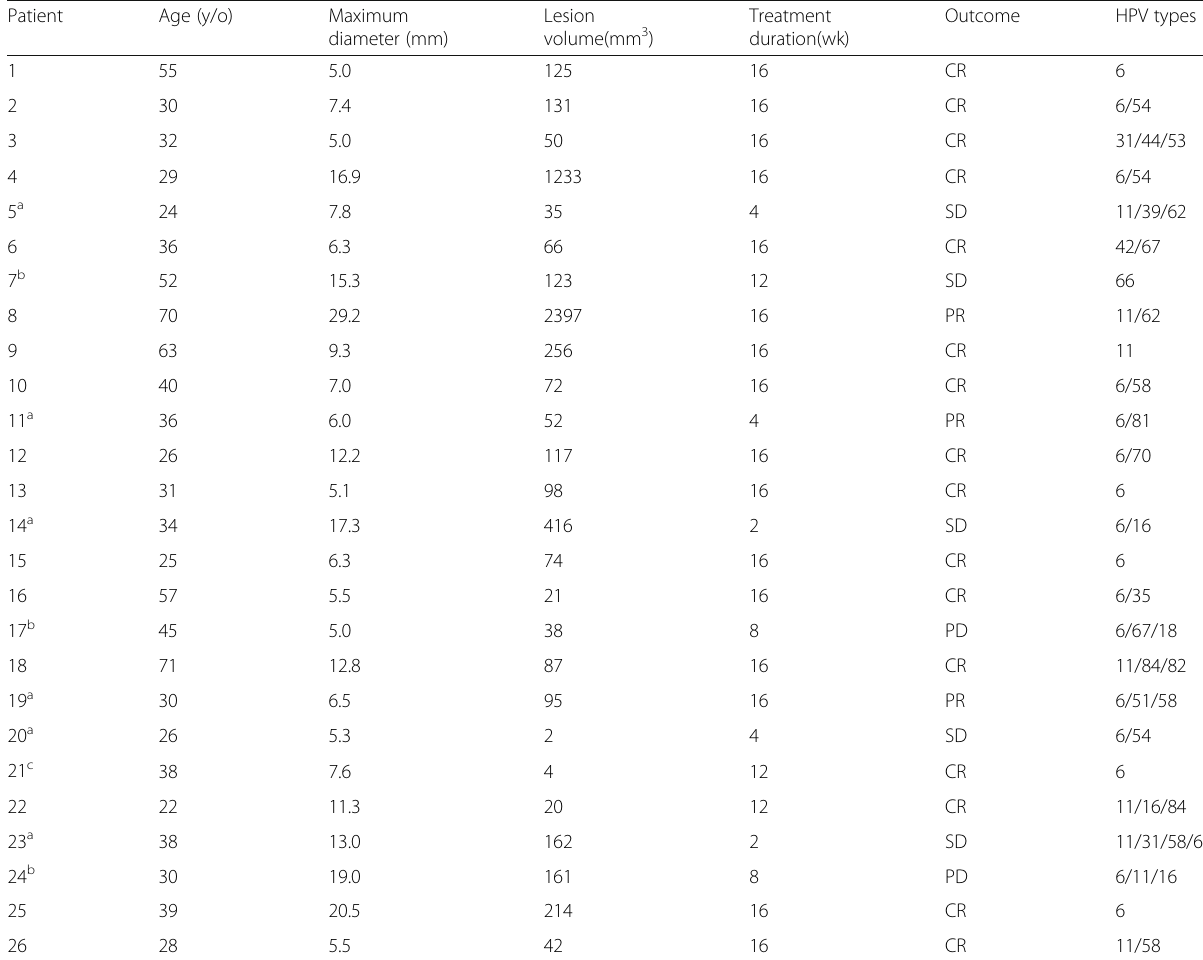
Table 1 Summary of patients with condyloma treated with SR-T100 gel Patient